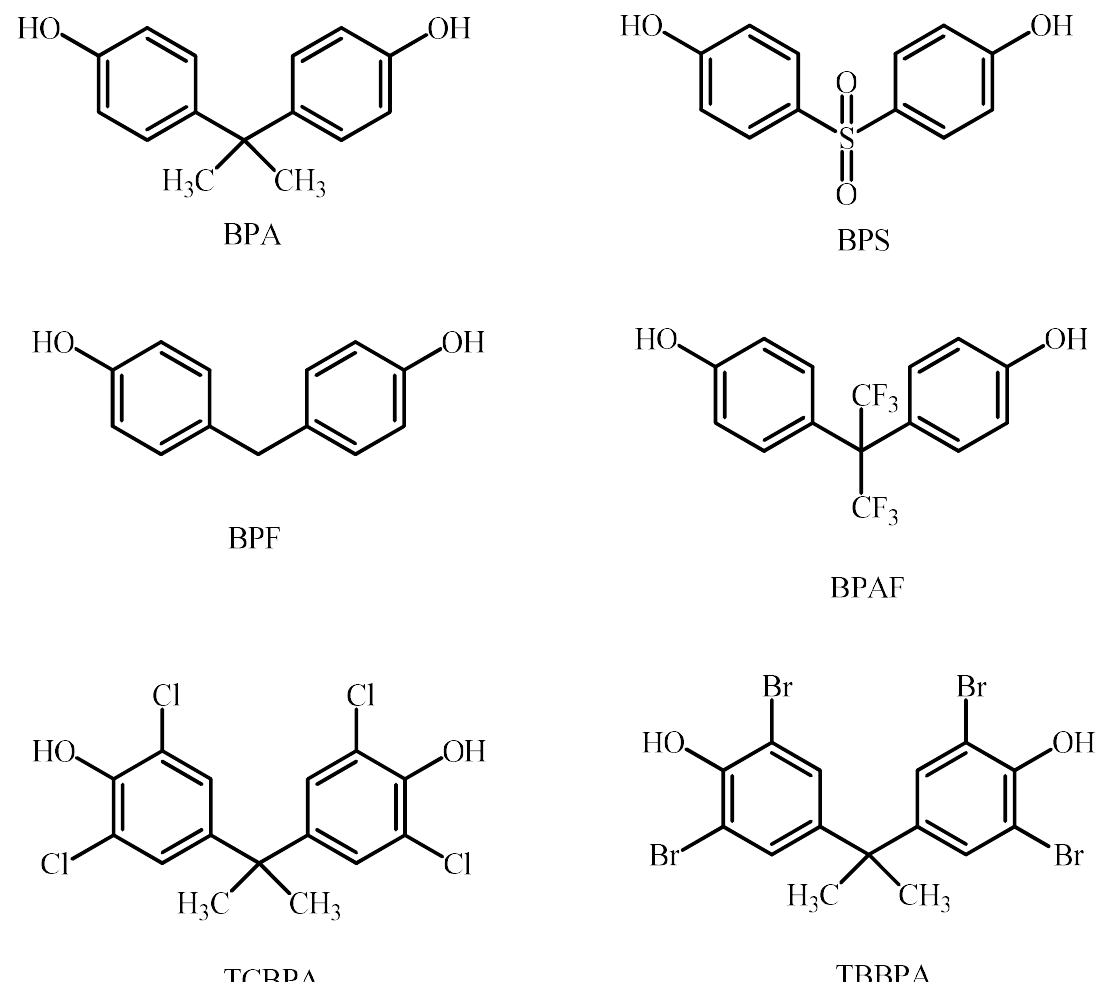
Figure 8. The structure of bisphenols that are most commonly used in polycarbonate plastics. Table 4. Application of MIPs for the determination of selected endocrine disrupting compounds in waters and wastewaters.